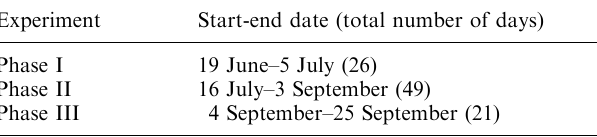
Table 2. The rain coupled with the high net radiation flux and specific soil texture results in a crust on the soil surface. We had to remove it twice during the 1997 WELSONS experiment (15 July and 3 September) by new tillage operations, and consequently this experiment has been divided into three periods. These repeated tillage processes allowed us to record enough data to characterize erosion processes and micrometeorological features. These periods must be distinguished because after a tillage operation, the soil structure is di(cid:128)erent, such as roughness length and soil properties